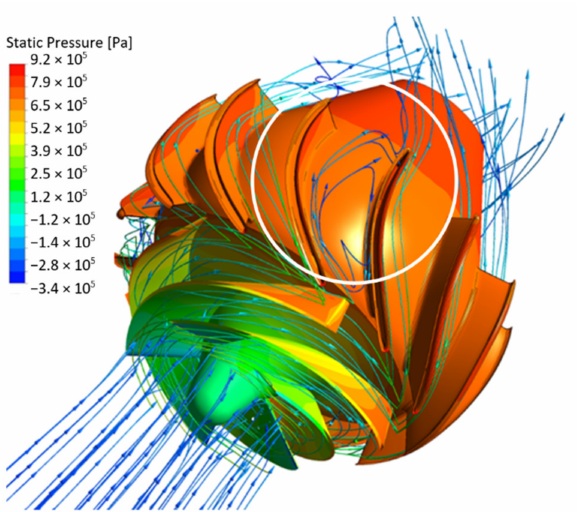
Figure 9. Discharge recirculation at a flow equivalent to 50% of QBEP. The fluid tends to recirculate from the guidevane back to the impeller. This circulatory flow can cause large forces on the impeller shrouds resulting in unbalanced axial forces and high thrust.